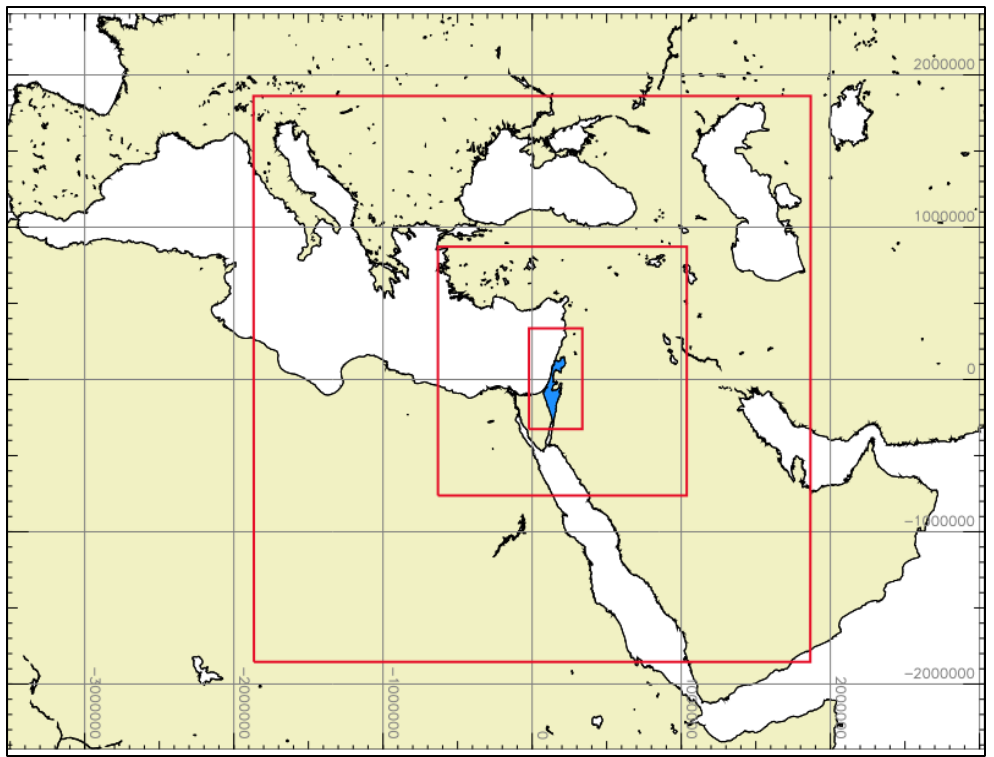
Figure 1. Map of the three nested Grids of Weather Research and Forecasting (WRF) simulations at the east Mediterranean (D1 = 27 km, D2 = 9 km, D3 = 3 km).